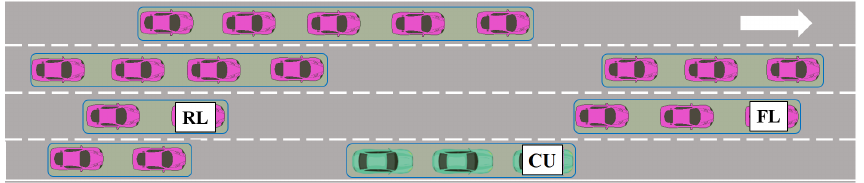
Figure 2. Illustration of forming a platoon in each lane and lane-change operations to maintain safety conditions if a platoon is changing its moving direction from the blocked lane to the free